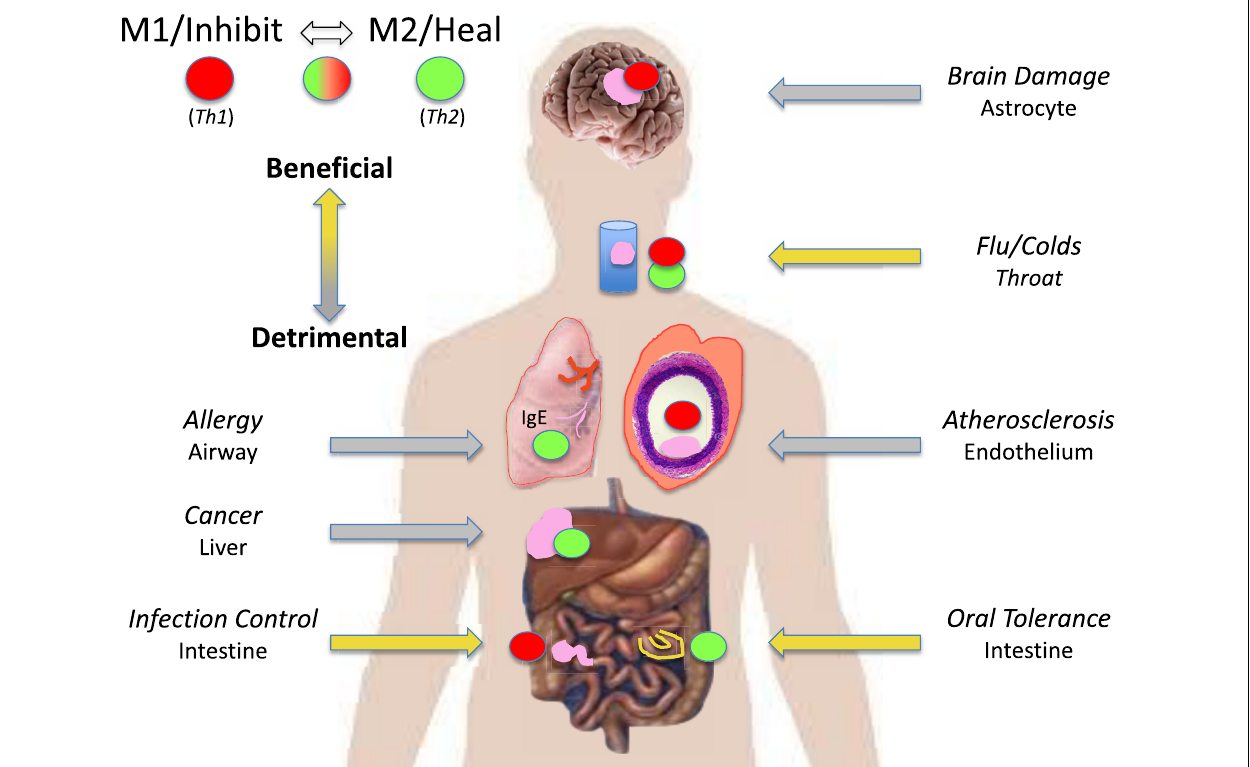
FIGURE 11 | M1/inhibit or M2/heal-dominant macrophage responses (or mixtures) can each be beneficial or detrimental depending on the disease circumstance . For example, M1/Th1-dominant responses are required to fight many infections (left). But, M1/Th1 responses are also causative of destructive inflammatory conditions in the brain and in atherosclerosis